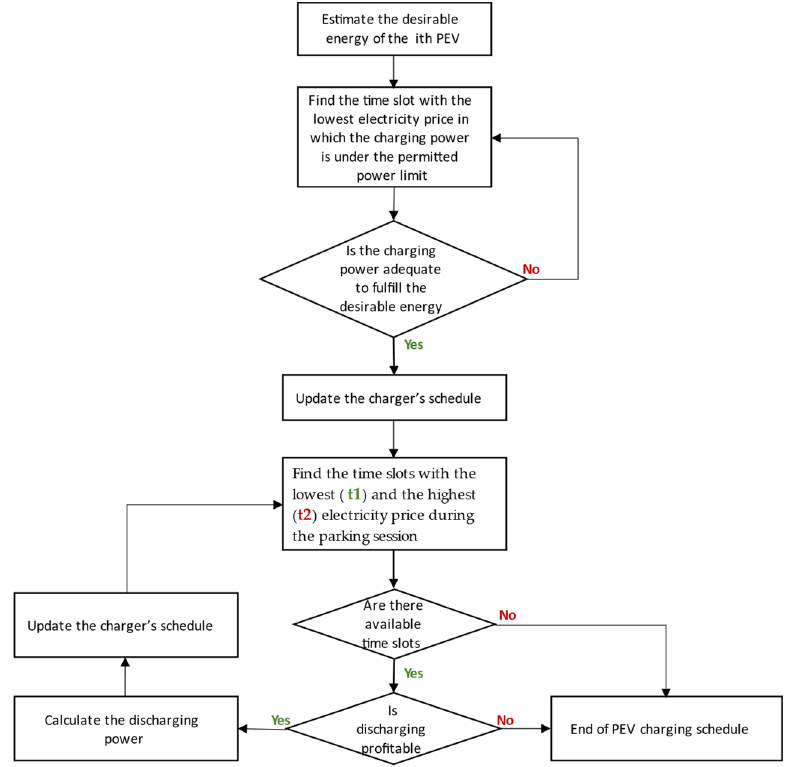
Figure 4. Flowchart of the proposed charging strategy.